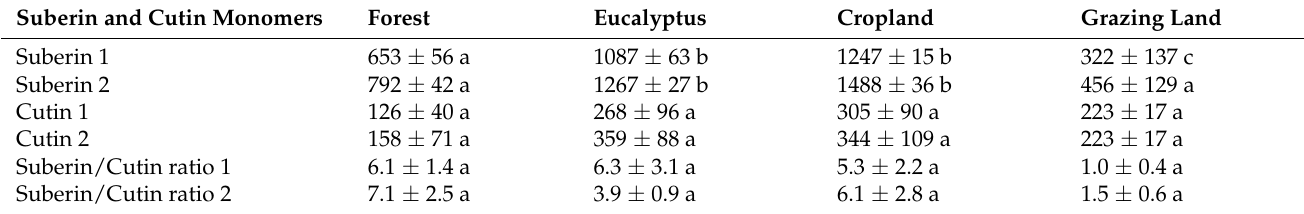
Table 4. Sums of suberin or cutin monomers ( µ g g − 1 C) identified from base hydrolysis of soil samples in different land-use systems in Gelawdios, Ethiopia (mean ± SE, n = 3). Different letters indicate a significant difference between land-uses ( p ≤ 0.05).